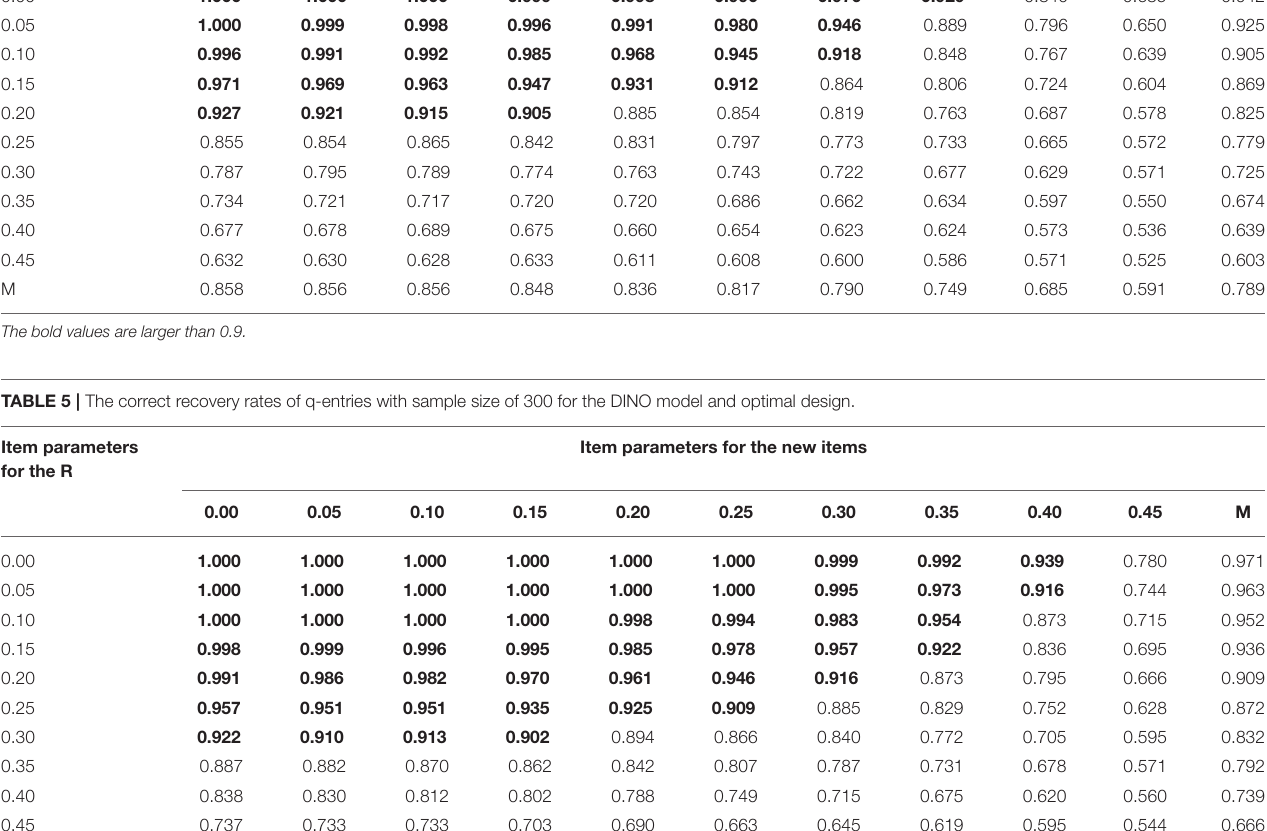
TABLE 4 | The correct recovery rates of q-entries with sample size of 300 for the DINO model and random design. Item parameters for the R